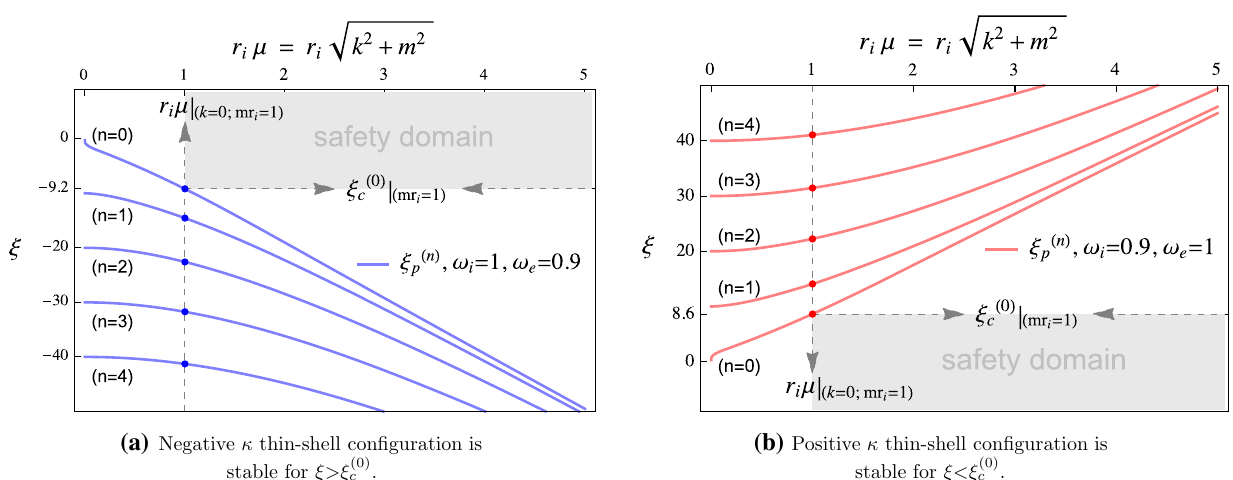
(b) Positive κ thin-shell configuration is stable for ξ<ξ (0) c .